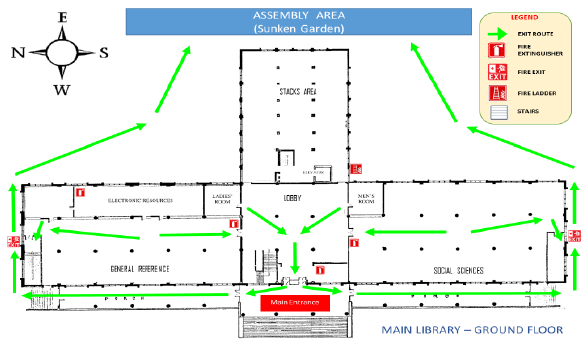
Figure 12. Currently Implemented Evacuation Ground Floor